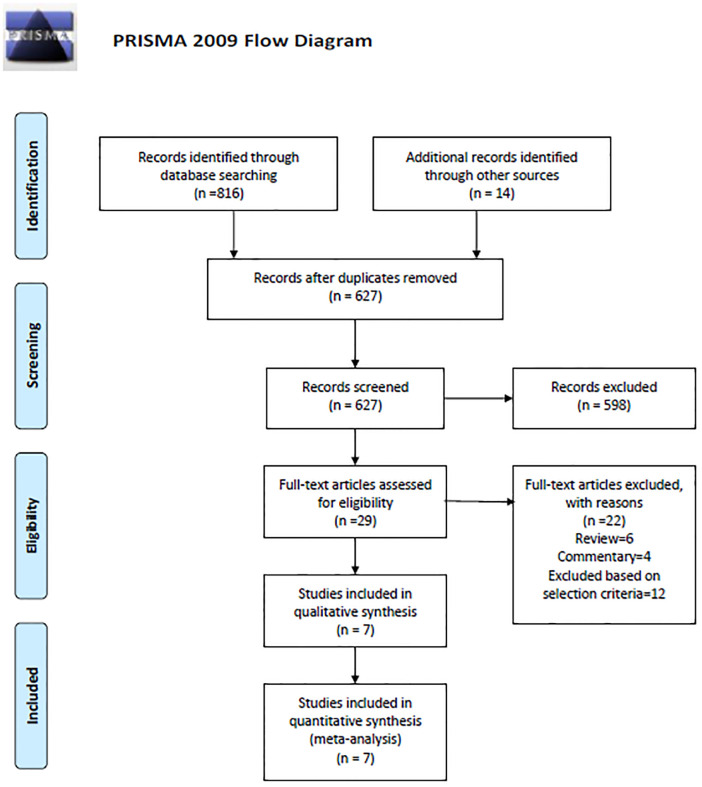
Flow chart of study selection process after screening of electronic search.